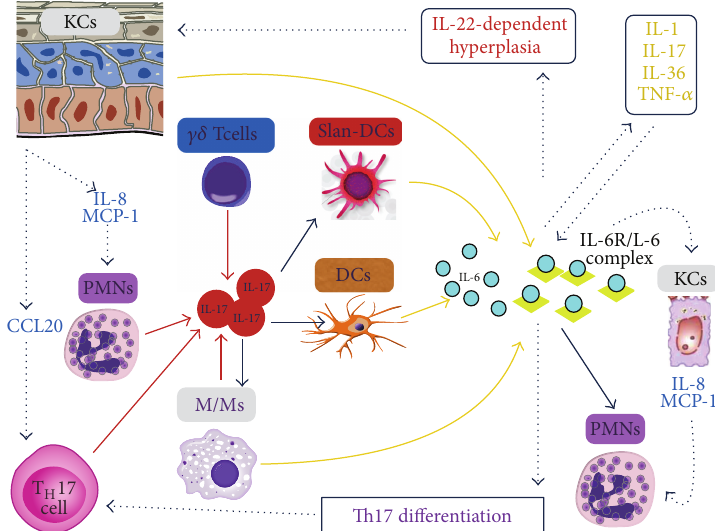
Figure 2: IL-17/IL-6 axis in the pathogenesis of pustular psoriasis. Both innate (gamma/delta T cells, neutrophils, and macrophages) and adaptive (Th17 cells) immunities contribute to cutaneous IL-17 production. Macrophages, conventional DCs, and slan-DCs respond to IL-17 by releasing IL-6, which in turn plays a key role in neutrophils recruitment and pustules formation; additional IL-6-dependent effects include reinforcement of Th1/Th17 inflammatory cytokines production, facilitation of IL-22-mediated epidermal hyperplasia, and naive CD4+ T cells differentiation into Th17. Activated keratinocytes amplify the IL-17/IL-6 axis by producing IL-6, recruiting Th17 cells through CCL20, and inducing neutrophils chemotaxis via IL-8 and MCP-1. DCs: dendritic cells; IL: interleukin; KCs: keratinocytes; M/Ms: monocytes/macrophages; PMNs: neutrophils; Th17: T helper 17